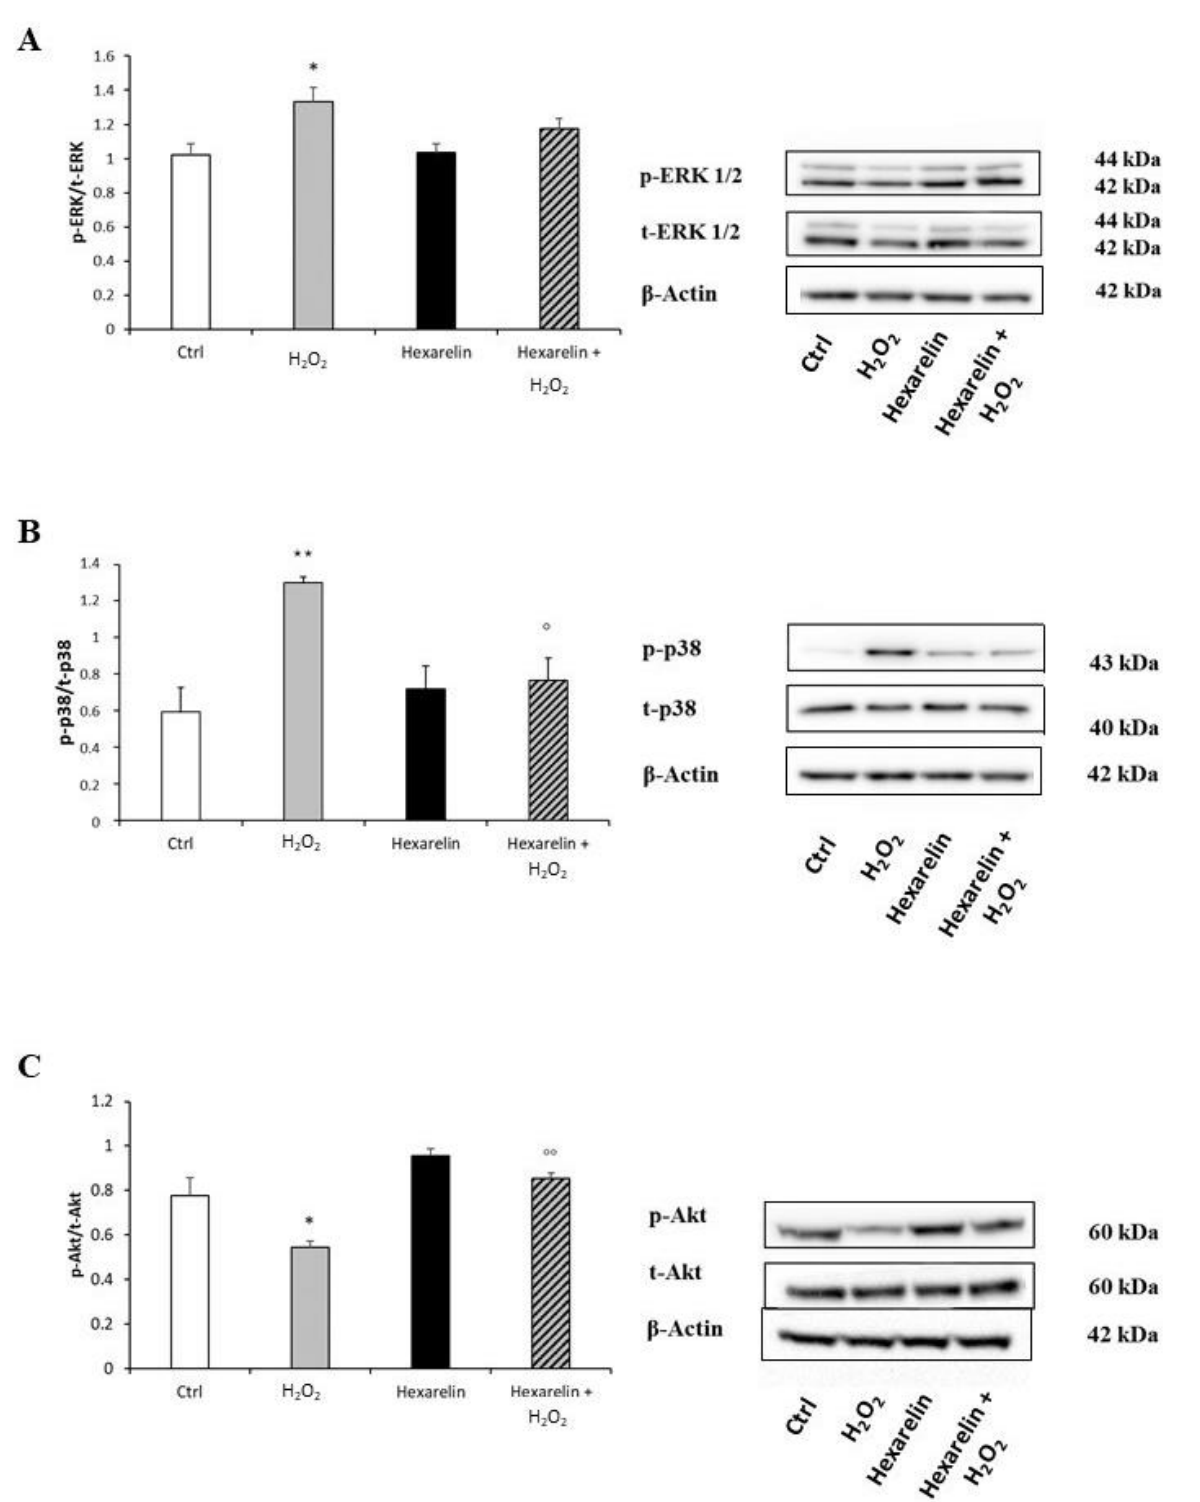
Figure 11. Hexarelin modulates ERK, p38 and Akt activation. Neuro-2A cells were treated with or without hexarelin and H 2 O 2 for 24 h and Western blot was used to measure p-ERK/t-ERK ( A ), p-p38/t-p38 ( B ), and p-Akt/t-Akt ( C ) levels. β -actin was used to control even protein loading in all lines. All assays were performed at least 3 independent experiments. Statistical significance: * p < 0.05, ** p < 0.01 vs. CTRL; ◦ p > 0.05, ◦◦ p < 0.01 vs. H 2 O 2 .